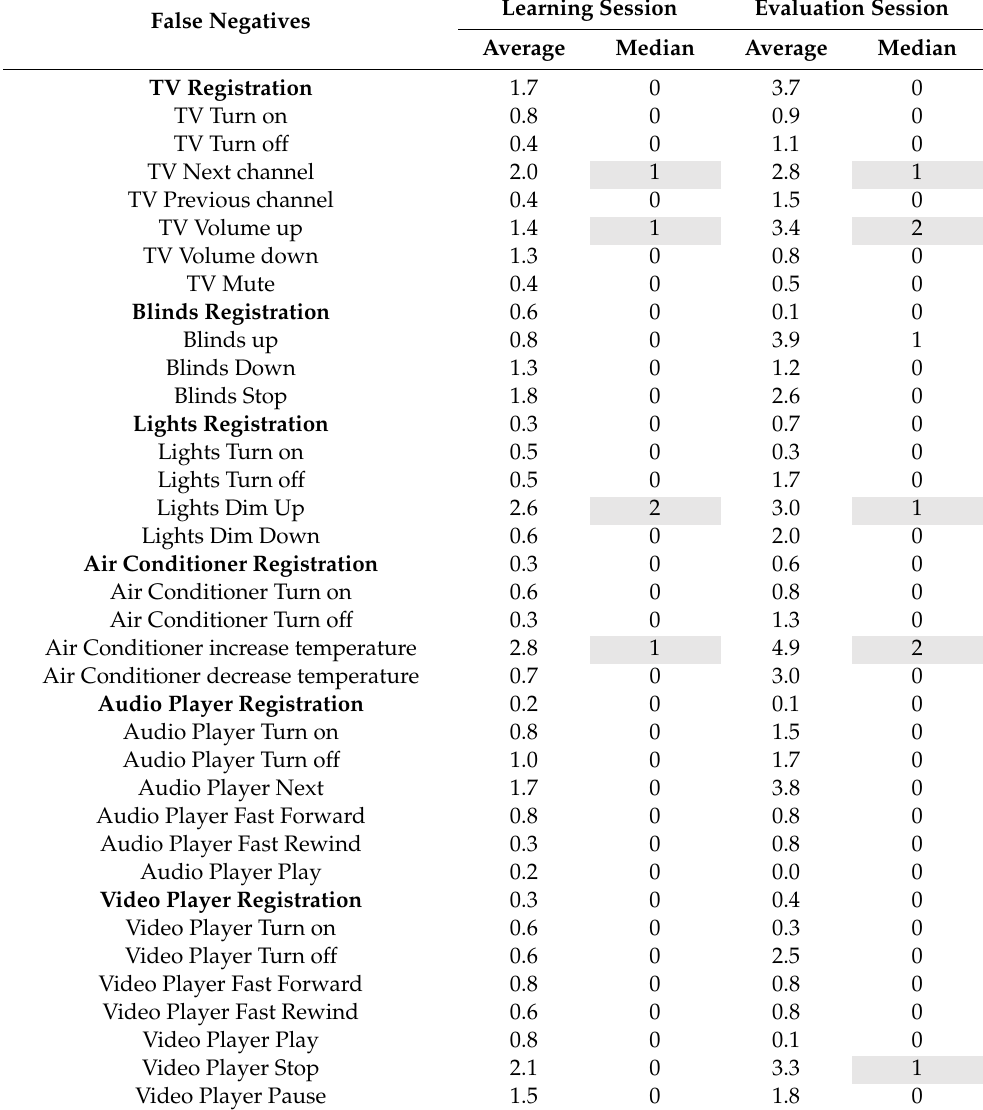
Table 5. False negative errors (average, median) for learning and evaluation session of mid-air interaction with multiple